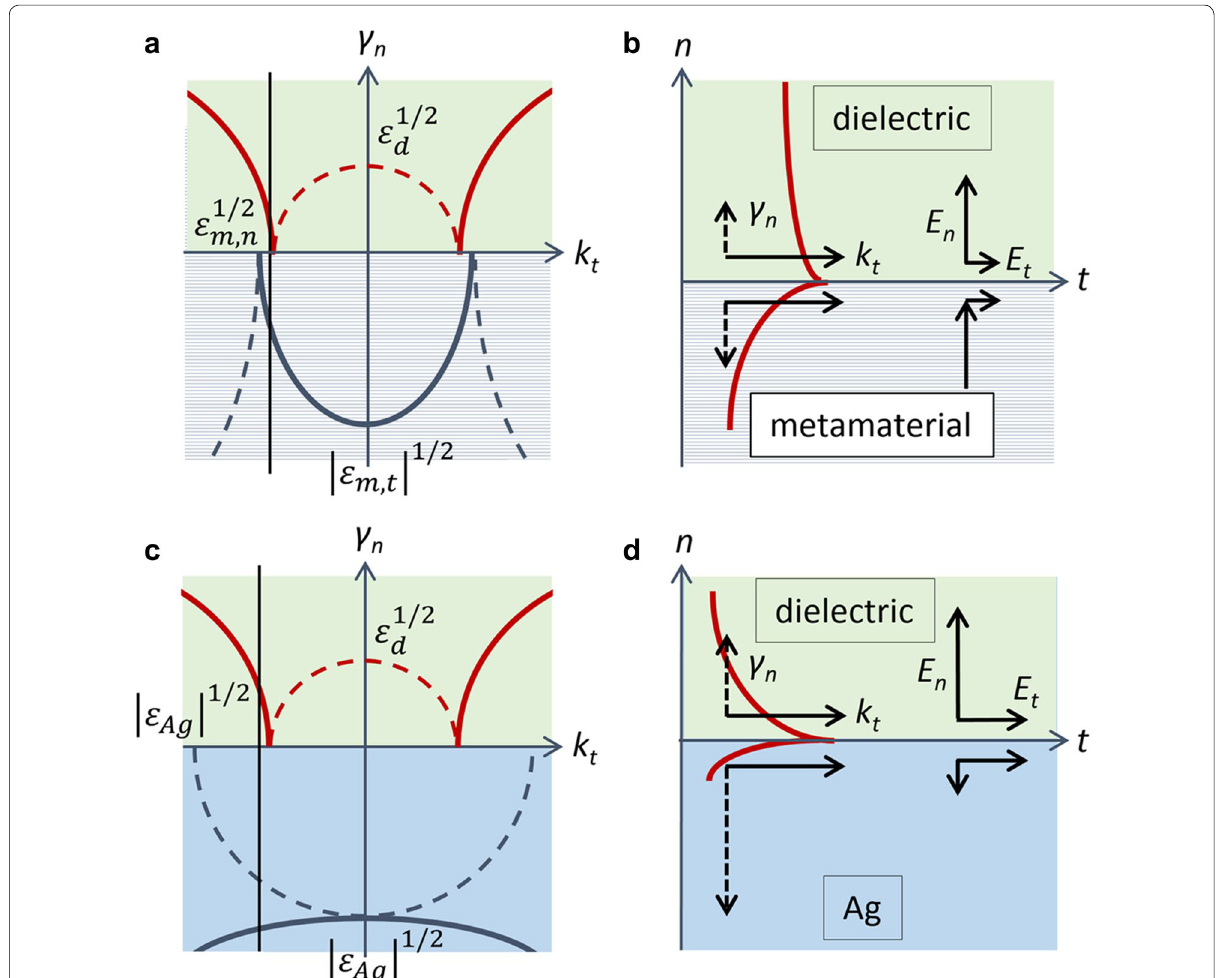
Fig. 4 Wave-vector diagrams and surface-plasmon field distributions. a Phase-matching point (solid, black vertical line) for metamaterial/dielectric interface, and wave-vector diagram displayed in the ( k t , γ n )-coordinate system. The red curve corresponds to wave-vector components ( k t , γ n ) in the dielectric side and the blue curve in the metamaterial side. The solid curve denotes evanescent waves and the dashed curve indicates propagating waves. b SP-field profile ( H z , red), and the relative amplitude and orientation of normal and tangential component of E -field (right). Note the loose confinement of SP field and the dominance of normal E -field. c Phase-matching point (black vertical line) at bulk metal/dielectric interface. d SP-field profile ( H z , red) and the relative amplitude and orientation of normal and tangential components of E -field (right). Note the strong confinement of SP field and the dominance of tangential E -field in metal